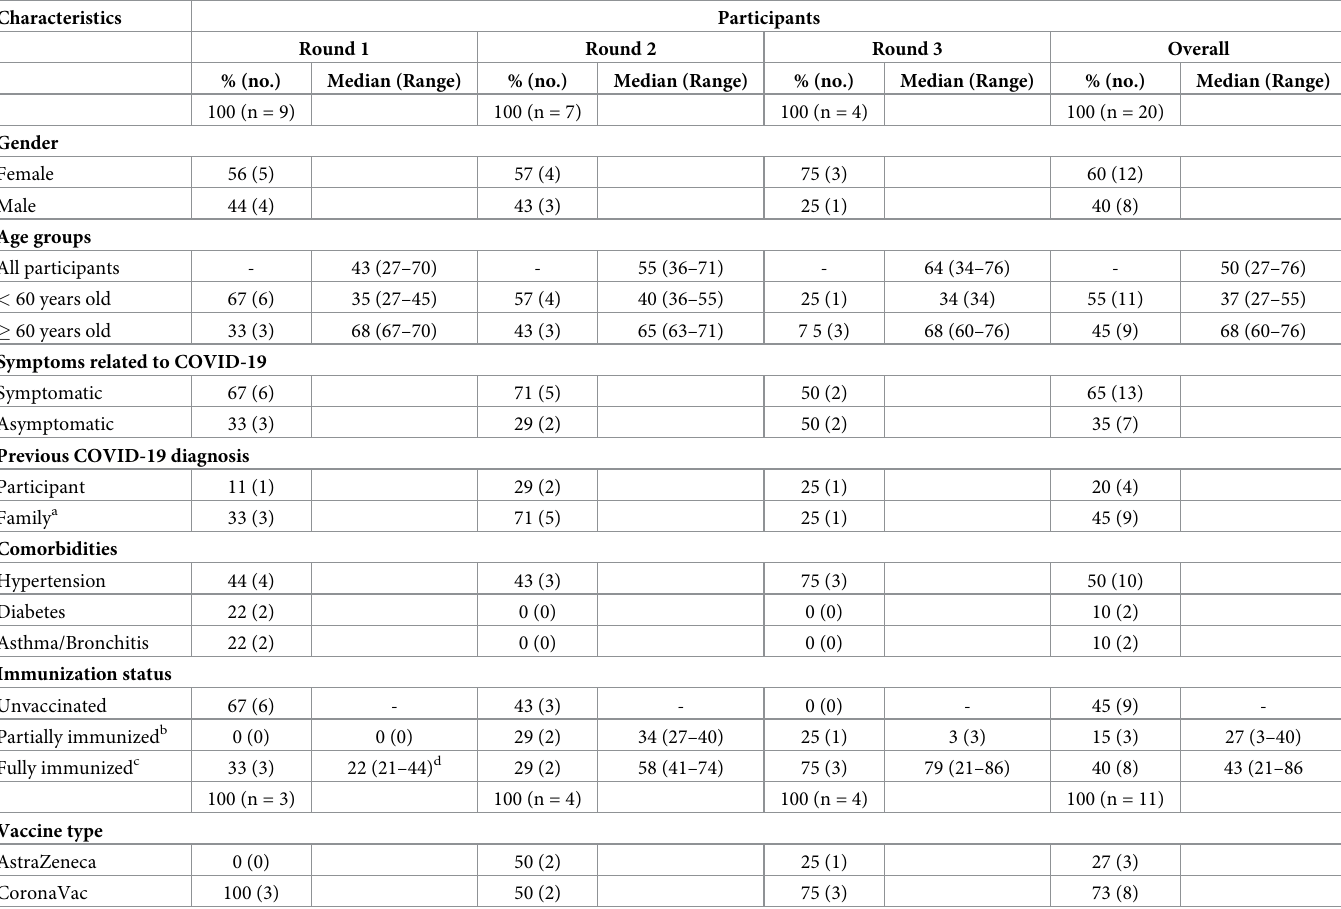
Table 2. Overview of all epidemiological and clinical data from RT-PCR positives individuals.